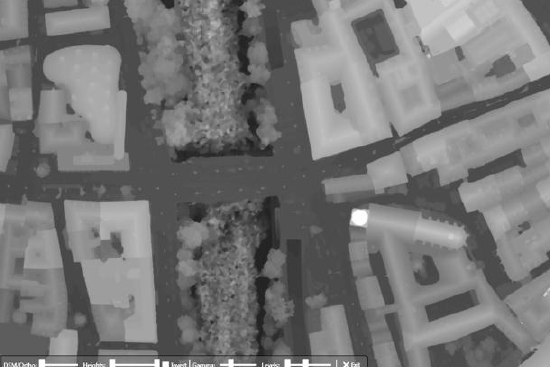
Figure 5. DSM generated from the point cloud by the UltraMap dense matcher module